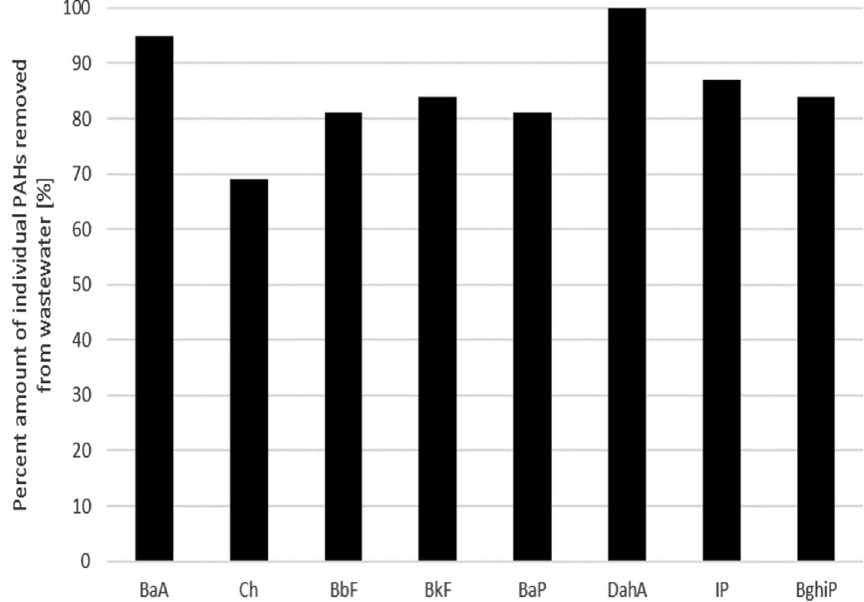
Fig. 9 Percent shares of indi- vidual PAHs amount removed from coke plant wastewater during the